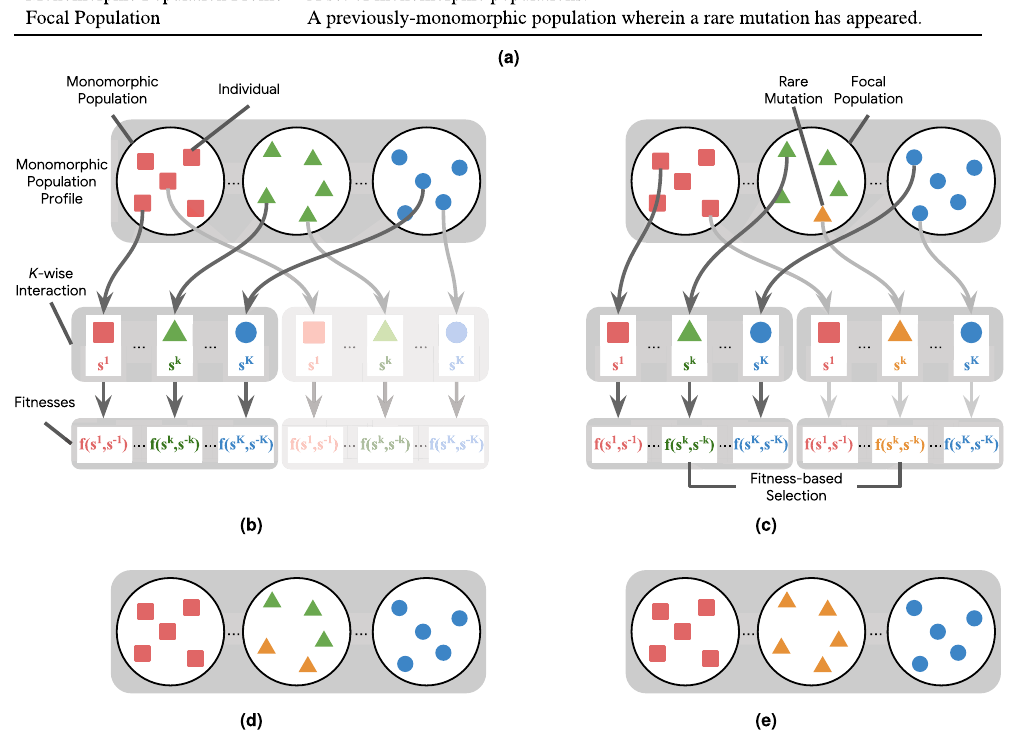
Figure 2. Overview of the discrete-time macro-model. ( a ) Evolutionary concepts terminology. ( b ) We have a set of individuals in each population k , each of which is programmed to play a strategy from set S k . Under the mutation rate μ → 0 assumption, at most one population is not monomorphic at any time. Each individual in a K -wise interaction game has a corresponding fitness − f s s ( , ) k k k dependent on its identity k , its strategy s k , and the strategy profile − s k of the other players. ( c ) Let the focal population denote a population k wherein a rare mutant strategy appears. At each timestep, we randomly sample two individuals in population k ; the strategy of population copies the mutant strategy. ( e ) The mutant propagates in the focal population, yielding a new monomorphic population